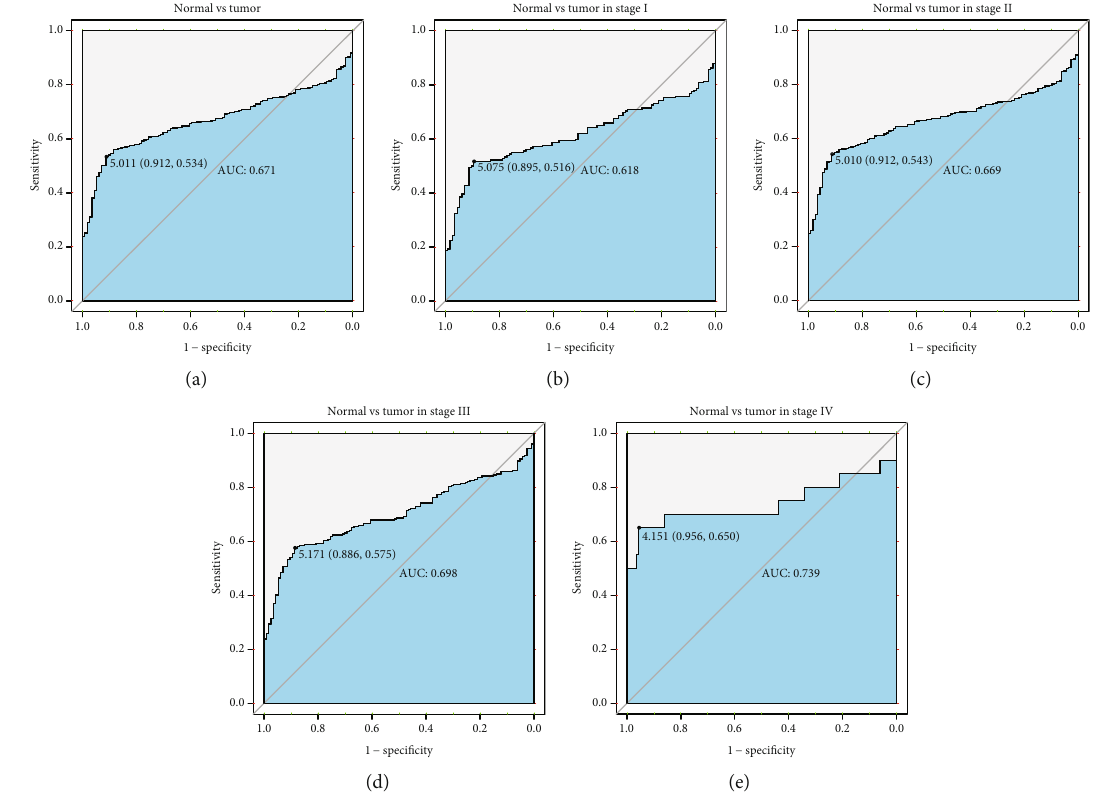
Figure 2: The diagnostic value of ZNF385B expression. (a) ROC curve for ZNF385B expression in breast cancer and normal tissue. (b – e) Di ff erent stages of breast cancer also showed certain diagnostic